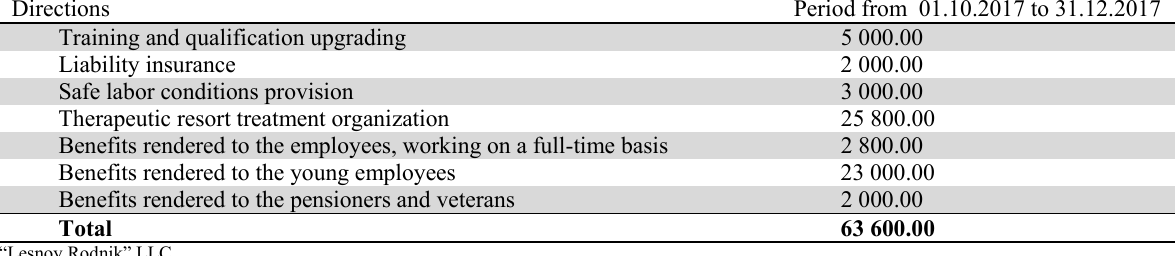
Form of non-financial reporting “Report: Expenses for nature protection events implementation” Directions Period from 01.10.2017 to